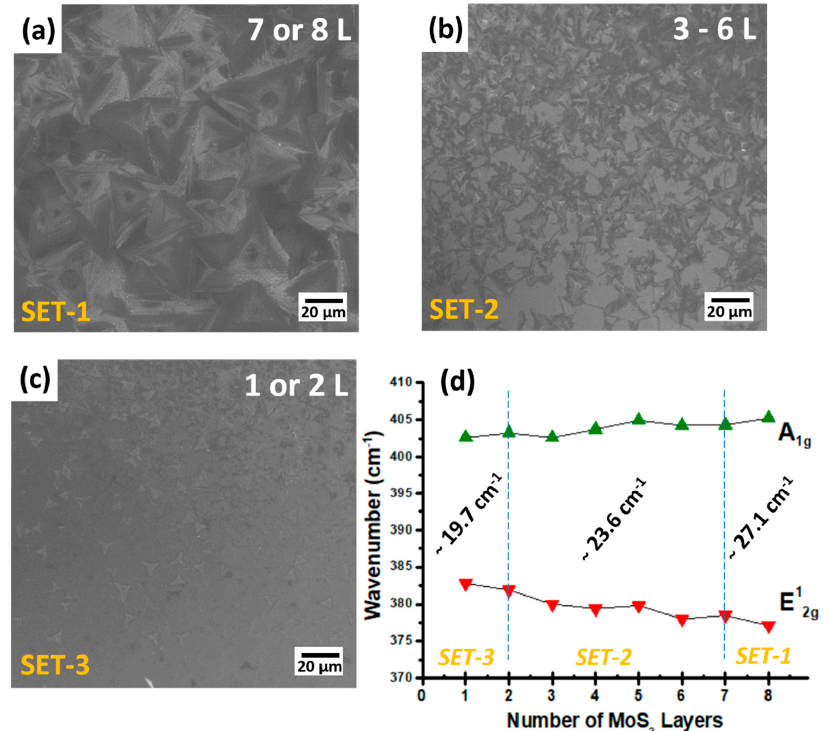
Figure 6. SEM images of MoS 2 growth at different vertical gaps corresponding to three sets: ( a ) 2 mm (Set-1), ( b ) 5 mm (Set-2), and ( c ) 10 mm (Set-3). ( d ) Raman data assessment of the positions of the A 1g and E 12g peaks depending upon the number of layers.